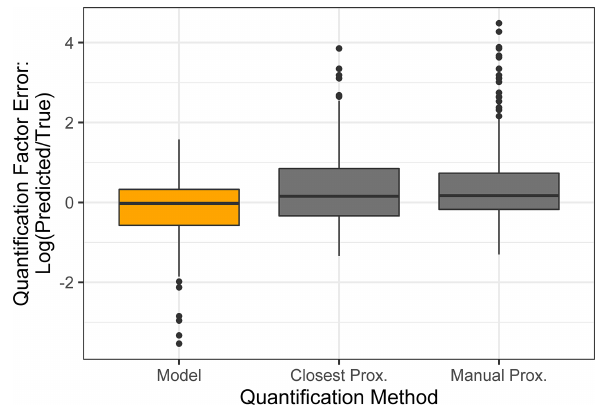
Figure A3. Normalized prediction residuals of the carbon oxida- tion state and vapor pressure vs. retention index for the ambient data compound property predictions set, overlaid with a compound number distribution over the retention index for ambient data set. The yellow highlighted region indicates compounds below a reten- tion index of 1500.